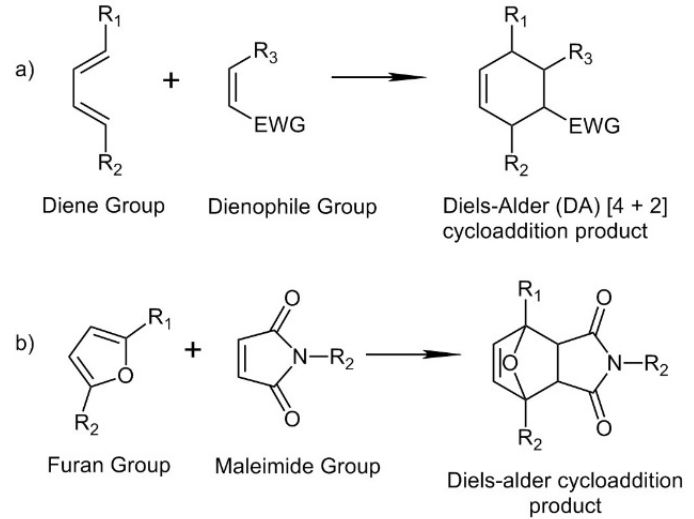
Figure 7. Diels–Alder formation: ( a ) Diels–Alder general [4 + 2] cycloaddition reaction. ( b ) DA cy- cloaddition reaction between furan and maleimide groups.